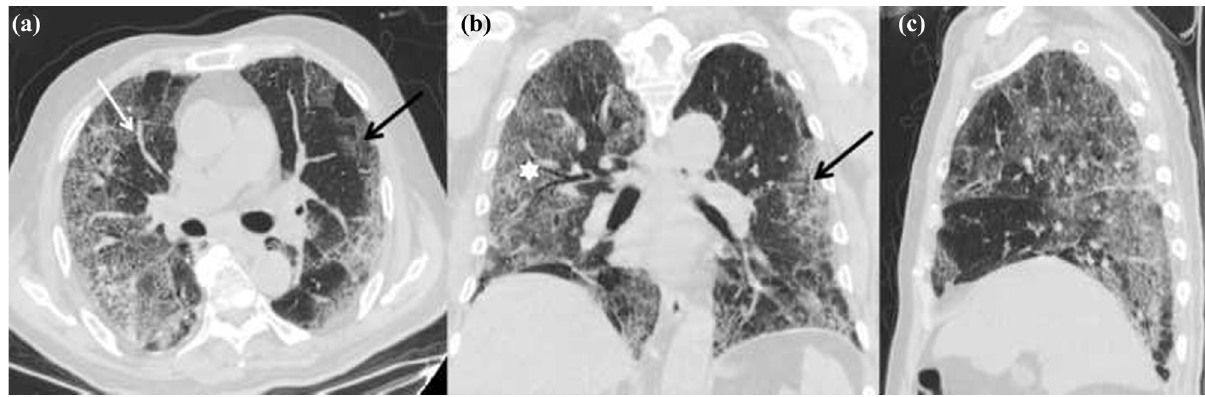
Figure 1: First CT scans of the patient ( a: axial noncontrast CT image; b: coronal thin - section noncontrast CT image; and c: sagittal thin - section noncontrast CT image ) showing large areas of GGO distributed mainly in subpleural ( black arrows ) , thickened vascular shallow ( white arrow ) , and bronchus shallow ( white asterisk ) .